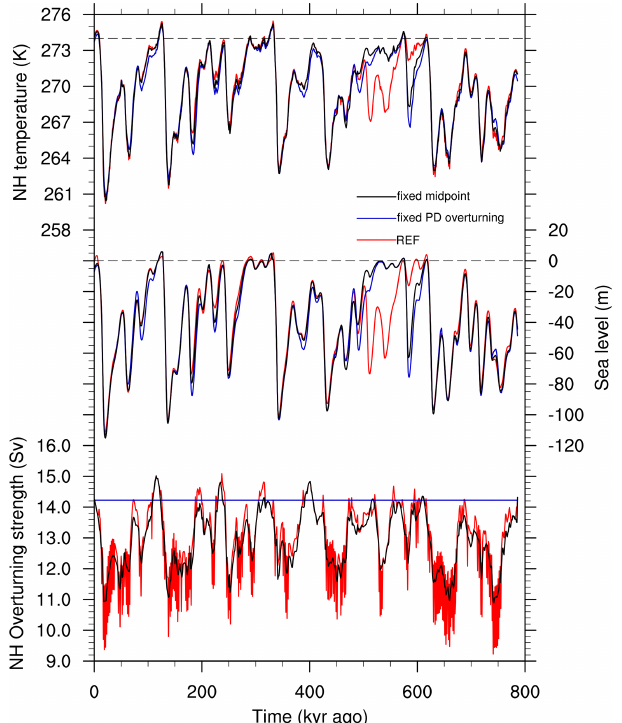
Figure 6. Modelled NH temperature (top), sea level relative to PD (middle), and NH overturning strength (bottom) for the reference run (red), a run with fixed PD overturning (blue), and a run with varying overturning strength but a fixed midpoint (black).